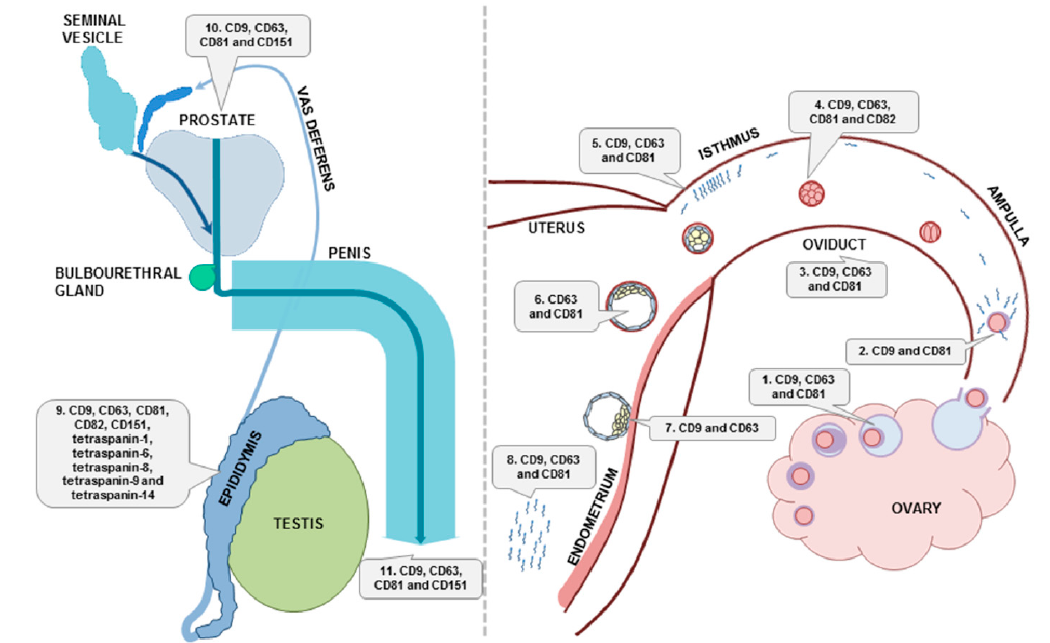
Figure 4. Schematic presentation of tetraspanins detected in extracellular vesicles within mammalian male and female reproductive systems. 1. CD9, CD63, and CD81 on EVs in follicular fluid during oocyte maturation; 2. CD9 and CD81 in EVs during fertilization; 3. CD9, CD63, and CD81 in EVs of oviductal fluid; 4. CD9-, CD63-, CD81-, and CD82-positive EVs produced by the early embryo; 5. CD9, CD63, and CD81 in EVs in the sperm reservoir in the isthmus; 6. CD63 and CD81 in EVs of blastocoel fluid; 7. CD9 and CD63 in EVs during embryo implantation; 8. CD9-, CD63-, and CD81-positive EVs in uterine fluid; 9. CD9, CD63, CD81, CD82, CD151, tetraspanin-1, tetraspanin-6, tetraspanin-8, tetraspanin-9, and tetraspanin-14 in EVs of epididymal fluid; 10. CD9, CD63, CD81, and CD151 in EVs related to prostate secretion; 11. CD9, CD63, CD81, and CD151 in EVs of semen.